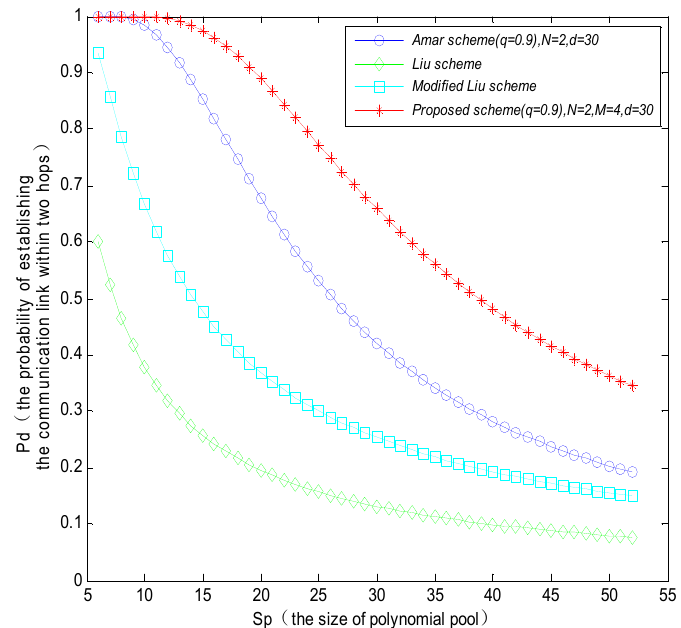
Figure 9. The probability that a MS and sensor nodes establish a communication link within two hops when the number of neighbor nodes d = 30.